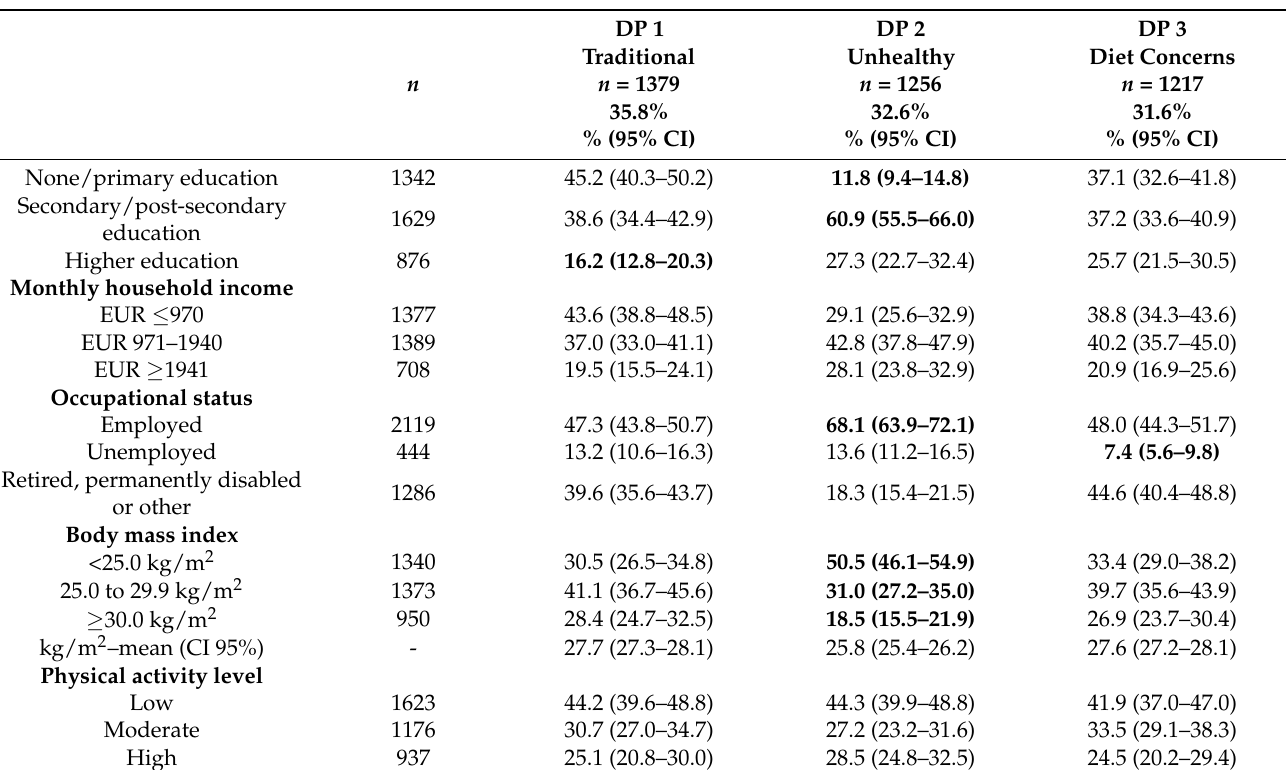
kg/m 2 –mean (CI 95%)